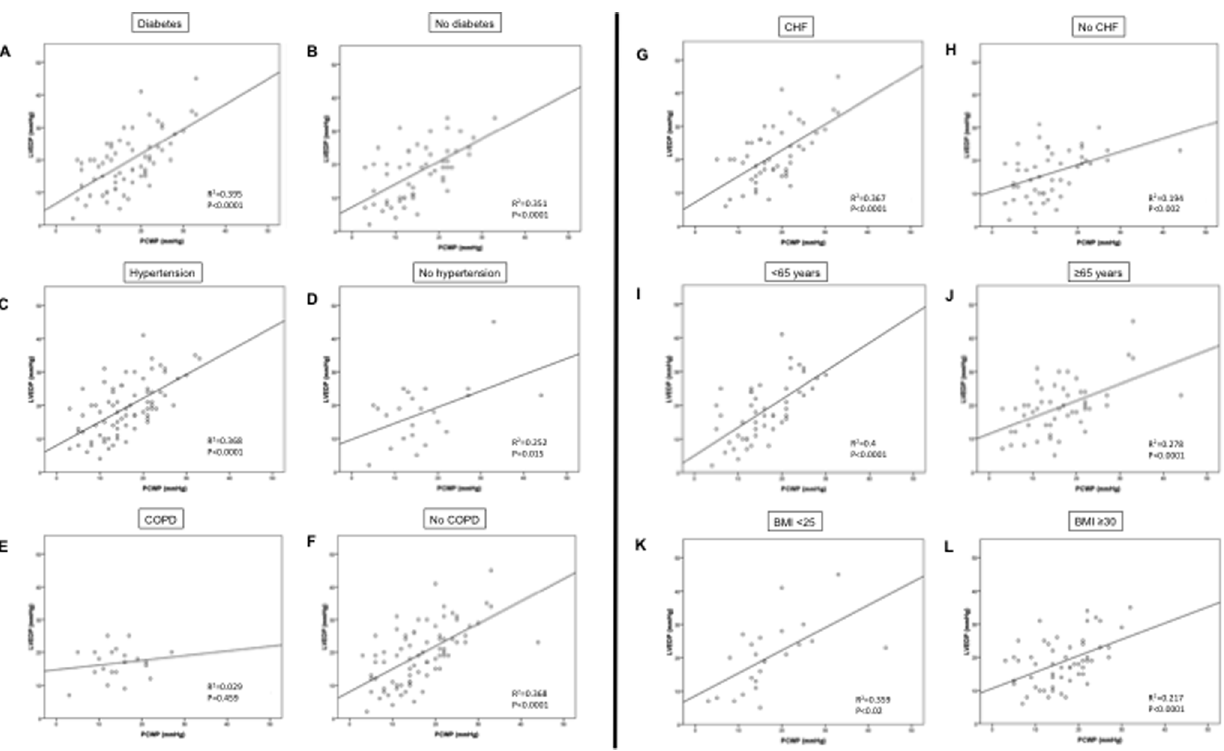
Figure 7. Correlations between PCWP and LEDP in patients with or without diabetes (A, B), hypertension (C, D), COPD (E, F) or CHF (G, H), as well as for patients , or $ 65 years of age (I, J), and for patients with a body mass index (BMI) , 25 or $ 30 (K, L). Note lack of significant correlation between PCWP and LVEDP in COPD patients, and poor correlation in obese patients.